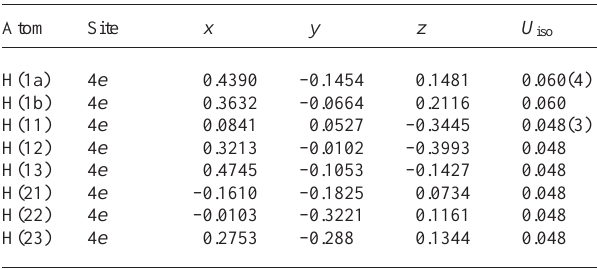
Table 2. Atomic coordinates and displacement parameters (in Å 2 )